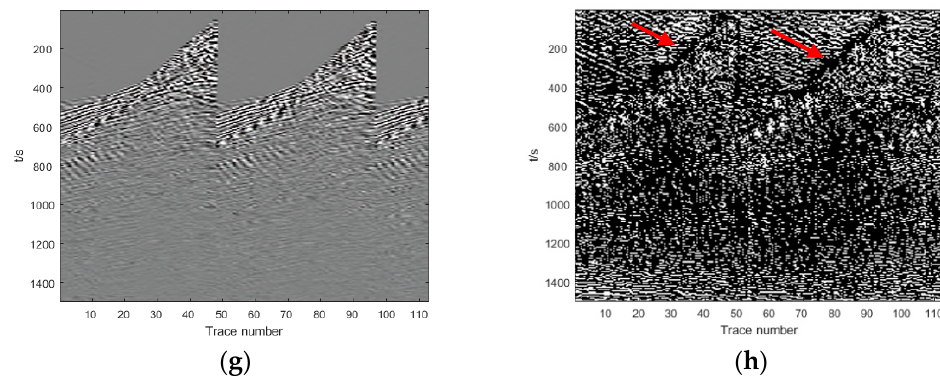
( g ) ( h ) Figure 16. Comparison of denoising performance under different parameters in the field example. The parts with obvious differences in the difference profiles are indicated by red arrows. ( a ) Denoised image when 𝛼 = 0.8, 𝛽 = 0.1; ( b ) The difference profiles when α = 0.8, β = 0.1; ( c ) Denoised image when α = 0.6, β = 0.2; ( d ) The difference profiles when α = 0.6, β = 0.2; ( e ) Denoised data when α = 0.4, β = 0.3; ( f ) The difference profiles when α = 0.4, β = 0.3. ( g ) Denoised data when α = 0.2, β = 0.4; ( h ) The difference profiles when α = 0.2, β = 0.4.